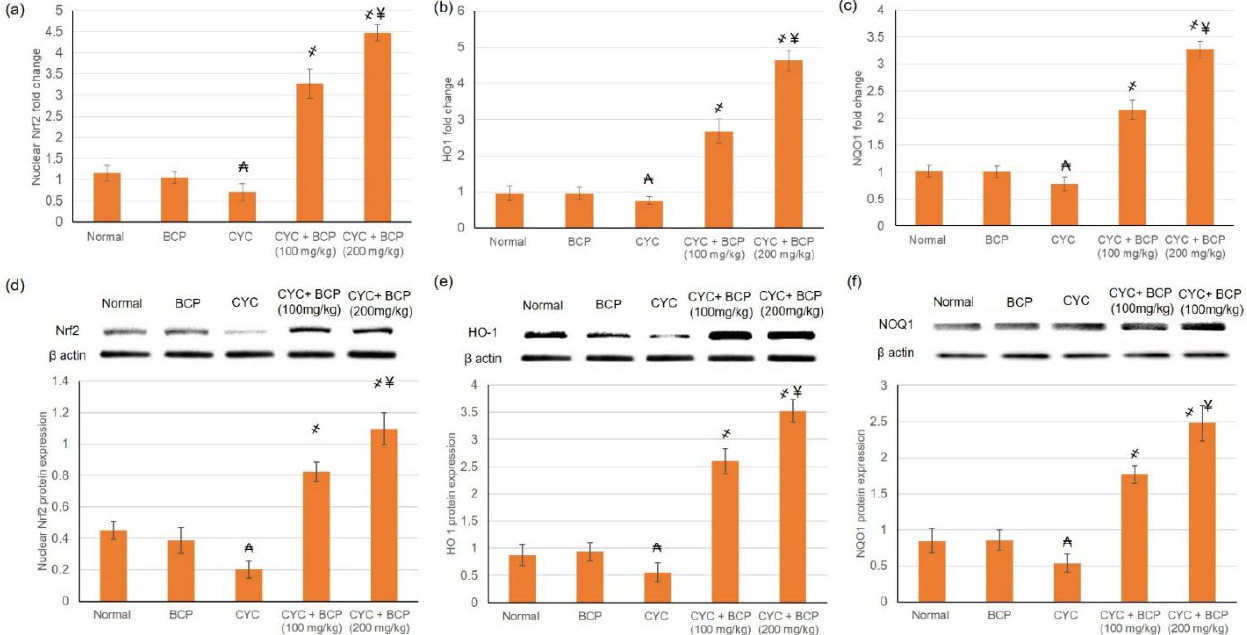
Figure 3. Effects of treatment with β -caryophyllene (BCP) for 14 days on cyclophosphamide (CYC) induced escalation in gene expression of ( a ) Nrf2, ( b ) HO1 and ( c ) NQO1 and protein expression of ( d ) Nrf2, ( e ) HO1 and ( f ) NQO1 in rats. All values are expressed as mean ± SD. ₳ indicates a statis- tically significant difference from normal group; indicates a statistically significant difference from CYC group; ¥ indicates a statistically significant difference from CYC + BCP (100 mg/kg) utilizing ҂ one-way ANOVA then Tukey’s post hoc analysis ( p < 0.05).